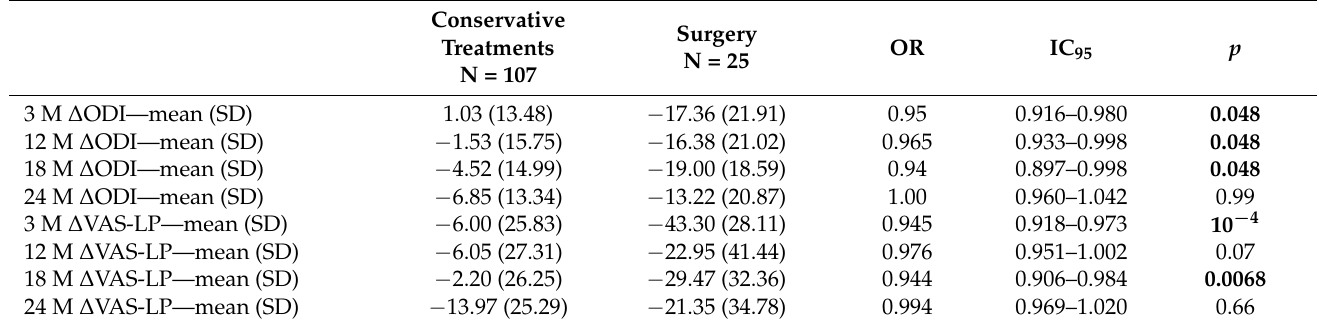
Table 3. Evolution of Oswestry disease index and leg pain VAS at 3, 12, 18 and 24 months (multivariate